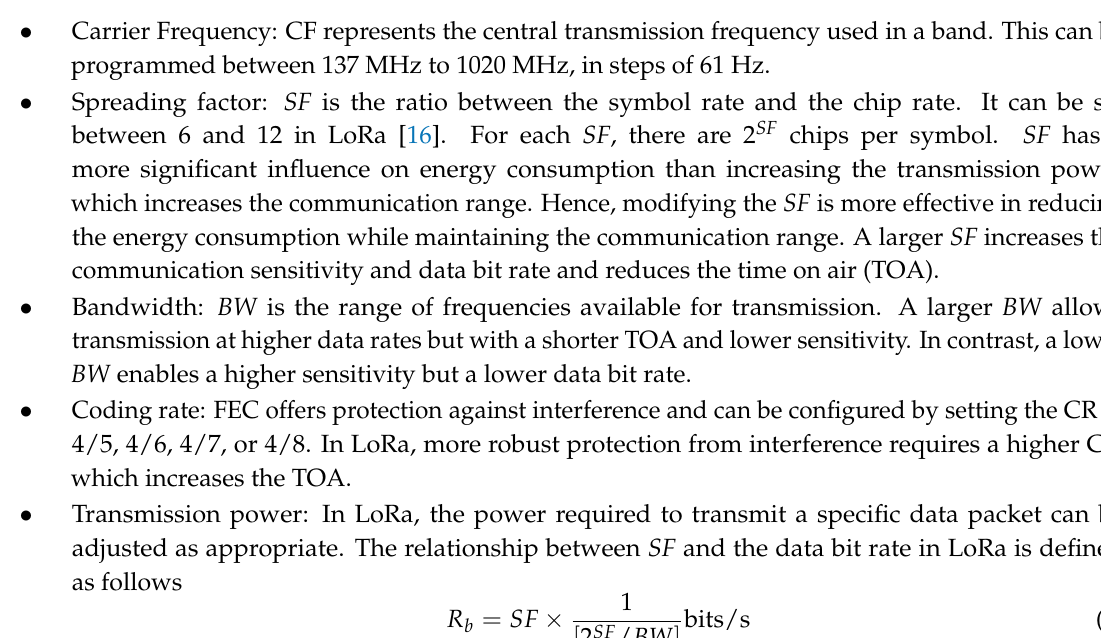
Table 1. LoRa parameter settings and their effects on communication performance [2]. Setting Values Effects A higher bandwidth is required for transmitting data at high Bandwidth 125, . . . , 500 kHz rates (1 kHz = 1 kcps). However, increasing this parameter decreases the communication range and sensitivity. A higher spreading factor ( SF ) increases the communication Spreading Factor 2 6 , . . . , 2 12 chips range, radio sensitivity, and the signal-to-noise ratio (SNR). symbol However, energy consumption consequently increases. Bigger coding rates increase the protection against decoding Coding Rate 4/5, . . . , 4/8 errors and interference bursts at the expense of longer packets and higher power consumption. The signal-to-noise ratio is increased by increasing the Transmission Power − 4, . . . , 20 dBm transmission power at the cost of energy